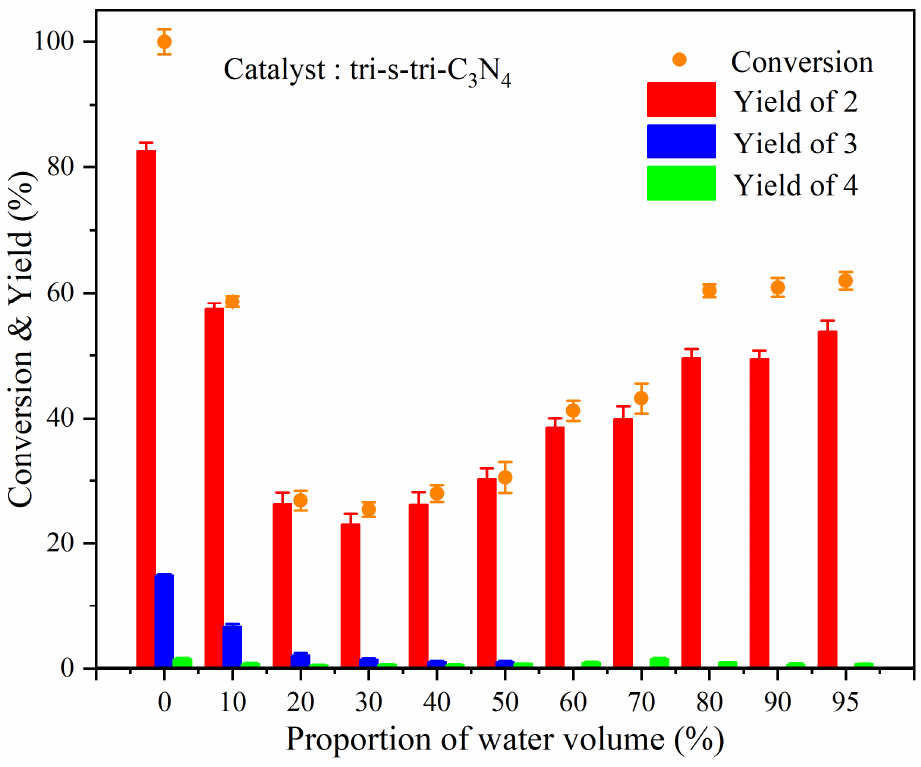
Figure 10. Photocatalytic conversion of ML using tri-s-tri-C 3 N 4 in water–acetonitrile solvent and